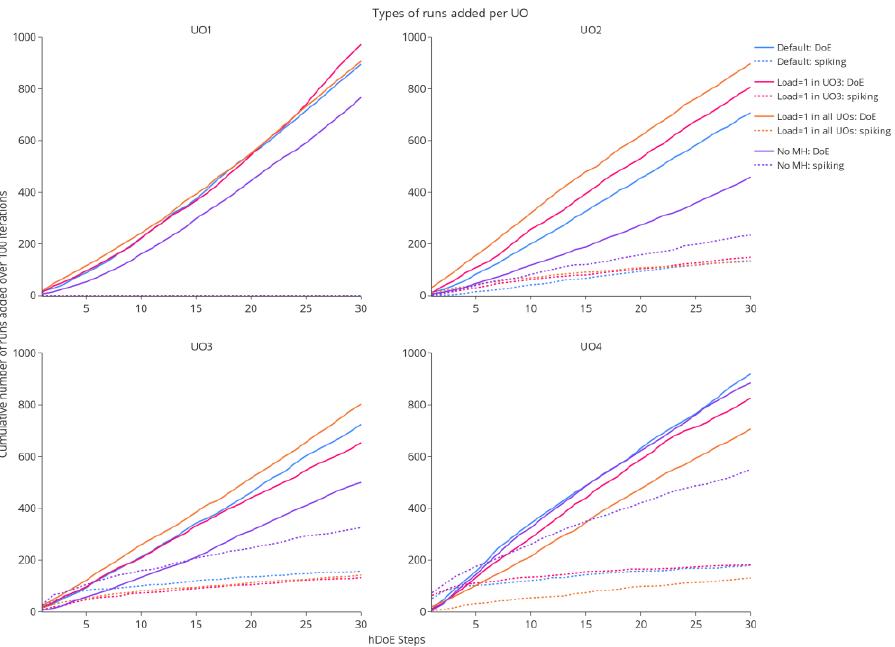
Figure 7. The cumulative allocation of either spiking or DoE runs in 100 repetitions of the simulation is shown over each step taken by the hDoE procedure (after the initial 24 runs). In total, each study distributes 100 × 30 = 3000 runs of any type to the four unit operations.